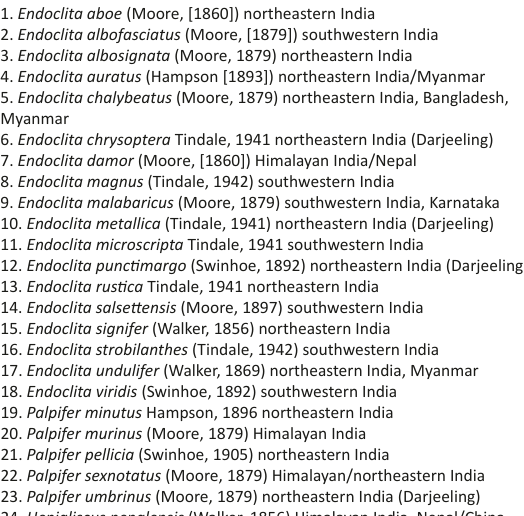
Table 1. Species of Hepialidae recorded from India 1. Endoclita aboe (Moore, [1860]) northeastern India 2. Endoclita albofasciatus (Moore, [1879]) southwestern